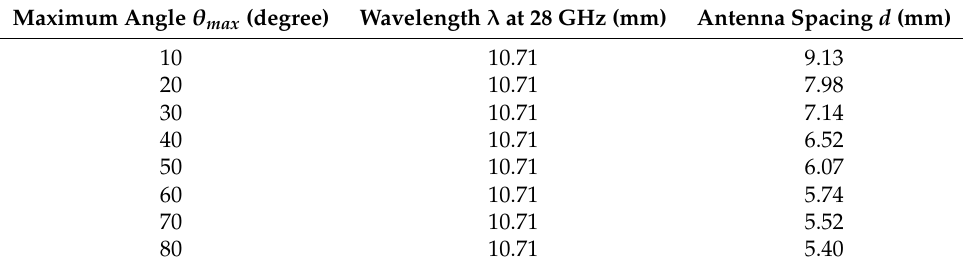
Figure 6. Directivity as a function of antenna spacing for a broadside array of isotropic elements [25]. The ideally maximum steering of the array antenna was ±90°. With that the antenna spacing was half the wavelength. In this study, the minimum spacing was 9.4 mm since the phasor IC was set at approached ±10°. Table 1. Maximum scan angle with di ff erent antenna Table 1. Maximum scan angle with different antenna spacing.